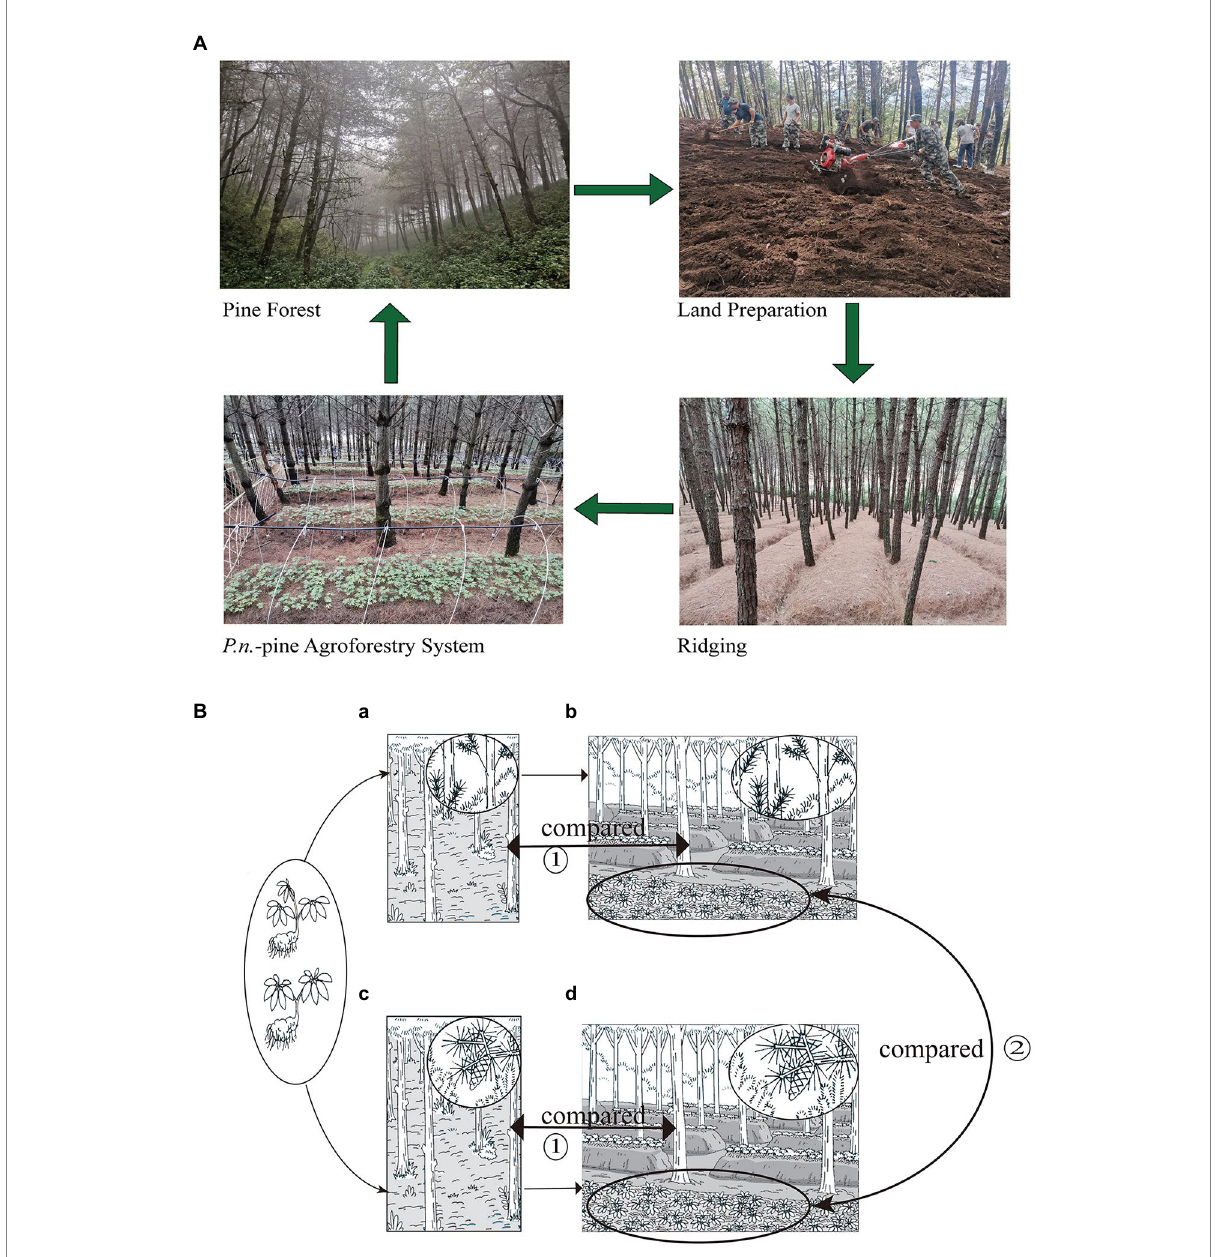
FIGURE 1 Specific planting process of the Panax notoginseng - pine agroforestry systems (A) and experiment design (B) . Experiment one ( ① ) compared the pure forests of P.k. (a) and P.a. (c) with the corresponding P.n. -pine agroforestry systems (b,d) for the difference of pine-associated microbes. Experiment two ( ② ) compared two P.n. -pine agroforestry systems (b,d) for the differentence of P.n. -associated